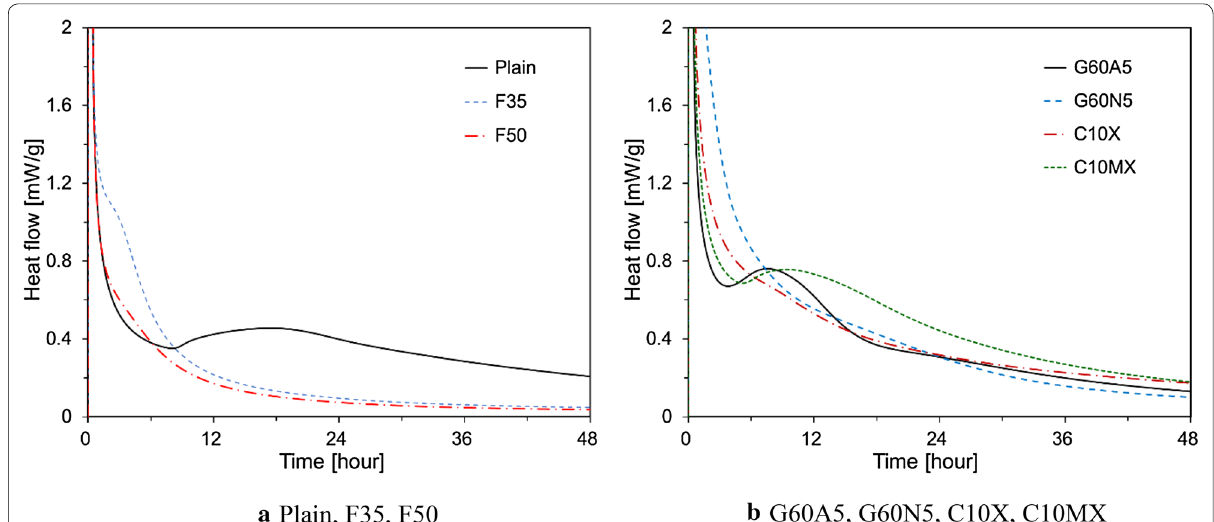
Fig. 6 Heat flow rate after 7 days of